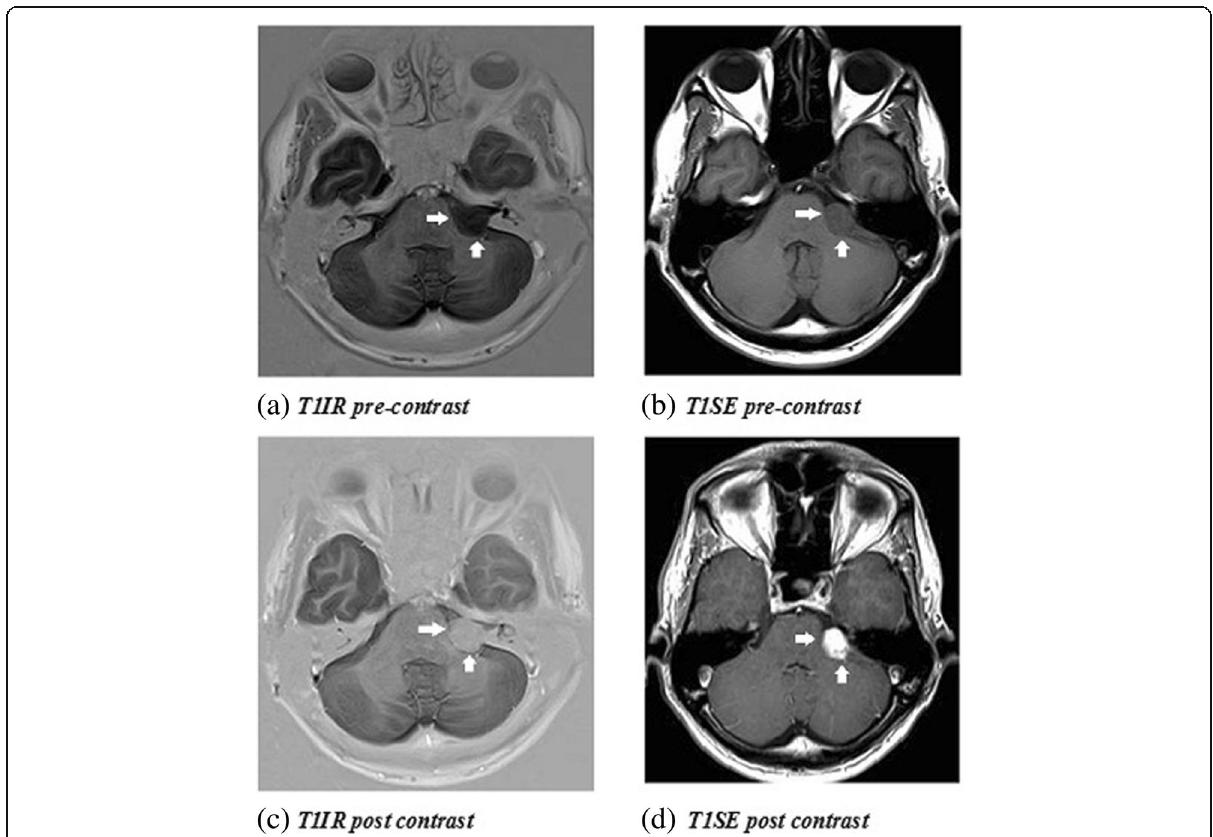
Fig. 2 Accidentally discovered posterior fossa mass. a T1IR pre-contrast. b T1SE pre-contrast. Posterior fossa lesion at left cerebellopontine angle that was better identified in T1IR than in T1SE as it appears with hypointense signals and higher lesion CNR than surroundings in T1IR with better delineation between its border and the adjacent left middle cerebellar peduncle (arrows in a , arrows in b ). c T1IR post-contrast. d T1SE post- contrast. After giving intravenous contrast media, the lesion appeared with homogenous enhancement in both sequences with no superiority of each of these sequences (arrows in c , arrows in d )